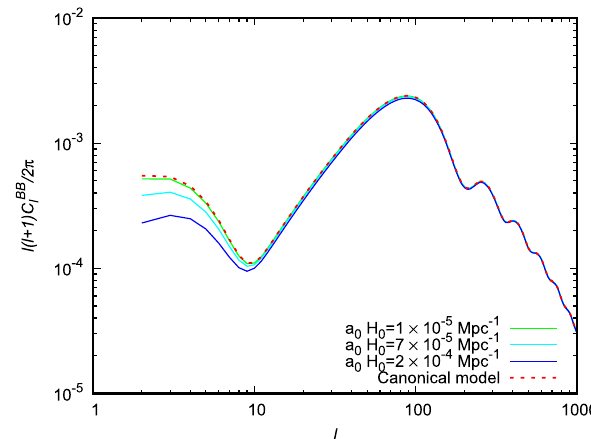
Fig. 1 Predicted B -mode spectra for different values of the collapse parameter B of the CSL model implemented in the emergent universe scenario. The canonical (cid:2) CDM model and the original emergent uni- verse (OEU) are also shown